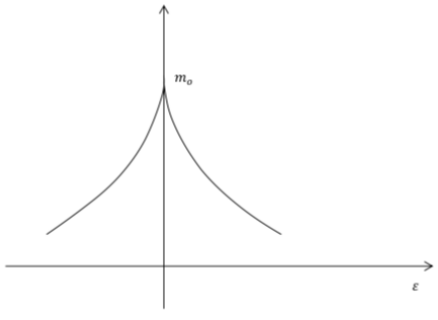
Figure 7. Thom’s cusp.